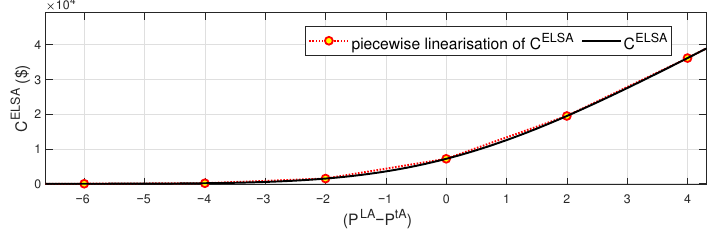
Figure 3. Piecewise linearization about C ELSA